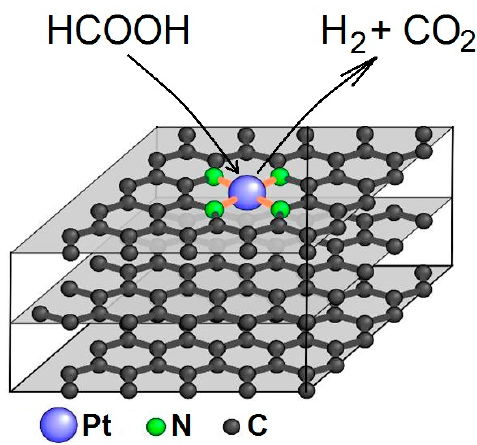
Figure 9. A model of a Pt atom stabilized on the N-graphene surface. Similar results were earlier reported for Pd/NC materials [19,20,53]. The results ob- tained by EXAFS are in a good agreement with the HRTEM data for the studied samples.